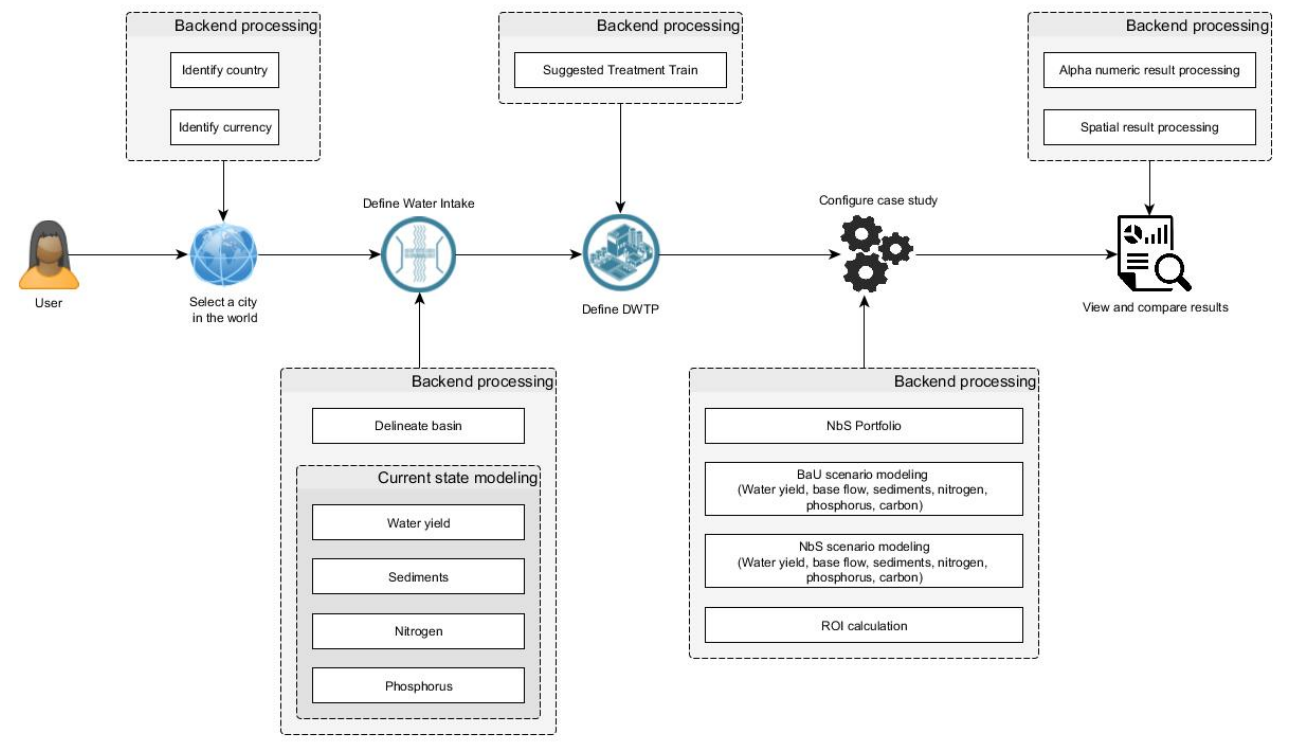
Figure 2. Analysis flow conceptualized for WaterProof .